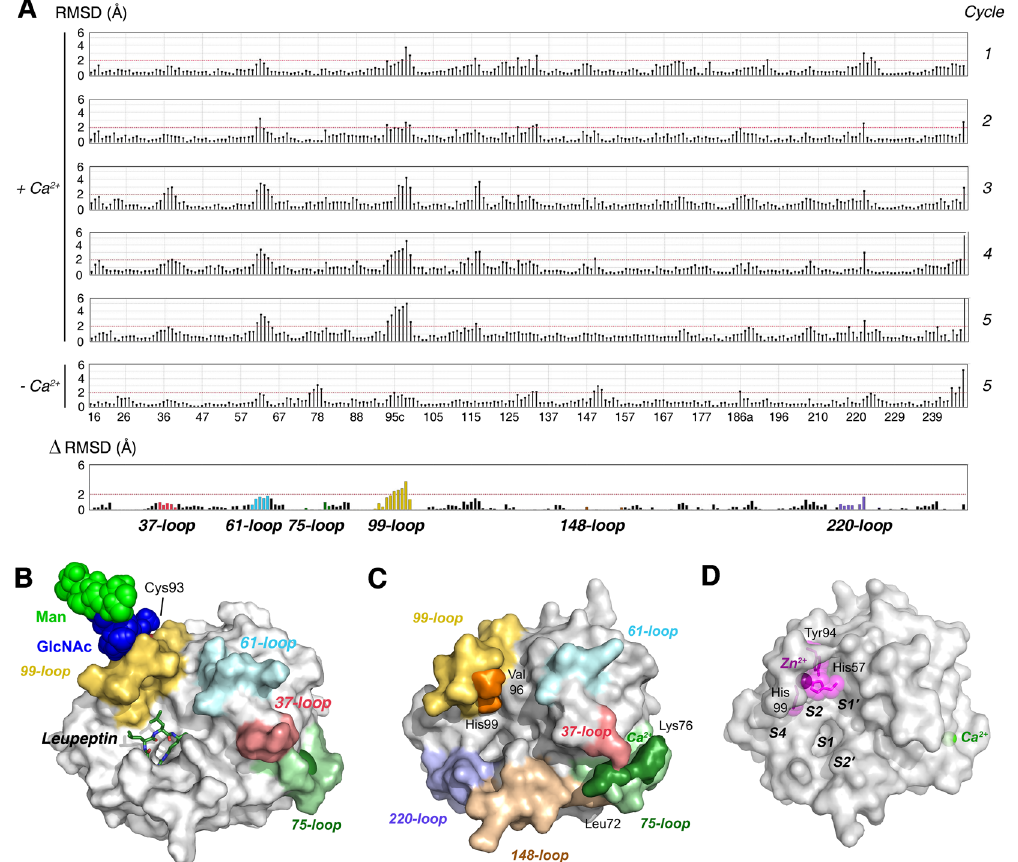
Figure 7. Molecular dynamics and the allosteric loop network of KLK8. ( A ) Plots of root mean square deviations (RMSD) in Å of KLK8 residue coordinates for five sequential MD production cycles at 298 K after the warm-up cycles, with respect to the final warm-up model. Data are depicted Ca 2 + bound to the 75-loop and the last cycle without Ca 2 + (chymotrypsinogen numbering). The significance level 2 Å (red line) is MOE default. For better visualization of loop motions, the RMSD difference ( ∆ ) of the models from cycle 5 [( + Ca 2 + ) − ( − Ca 2 + )] was calculated. Whereas the Ca 2 + bound 75-loop seems more stationary, the 37-, 61-, and mainly the 99-loop exhibit large motions. This finding indicates an allosteric communication line between these loops. ( B ) Model from MD calculations of KLK8 shown as surface with colored loops with a core glycan linked to Asn95, consisting of two GlcNAc (blue spheres) and three mannoses (light green). Ca 2 + (green) is bound to the 75-loop and leupeptin from the crystal structure is overlayed as stick model at subsites S4 to S1, in order to emphasize the wide open 99-loop (yellow) conformation, which seems to be facilitated by the presence of the glycan. The glycan may prevent cleavage in the 99-loop and disulfide formation of Cys93. ( C) In MD calculations of glycan-free KLK8 were similar as for glycosylated KLK8. Upon removal of Ca 2 + , the 75-loop closes the substrate binding cleft in the prime side near the 37-loop. The concomitant closure of the S2 pocket by Val96 and His99 (orange) in the 99-loop might hamper binding of small substrates. The labeled loops around the active site represent the allosteric network of various trypsin-like serine proteases, which may regulate substrate access 52 . ( D ) Zn 2 + -binding would similarly close the S2 pocket and inactivate KLK8 by rotating the His57 side chain away from the catalytic triad. Such a conformation was observed in the structure of rat tonin